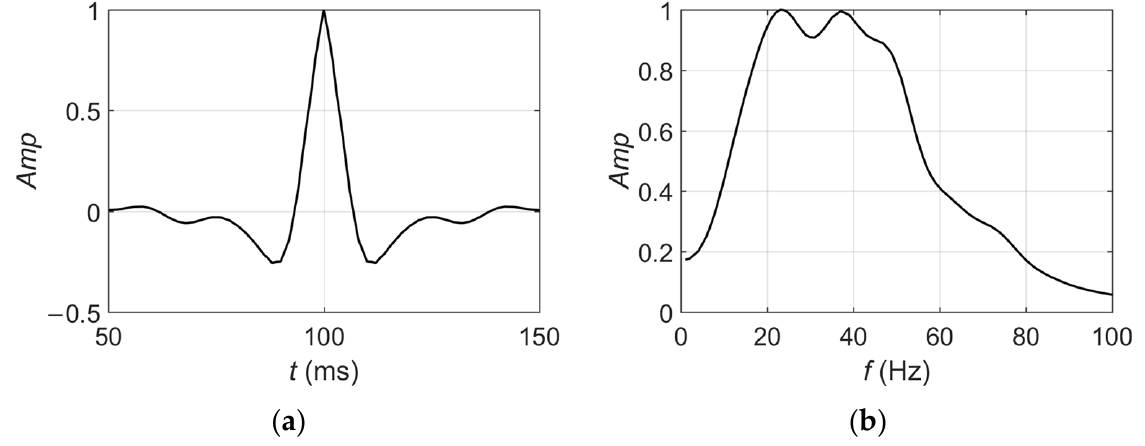
Figure 7. Seismic wavelet in the ( a ) time and ( b ) frequency domains, extracted from seismic data.